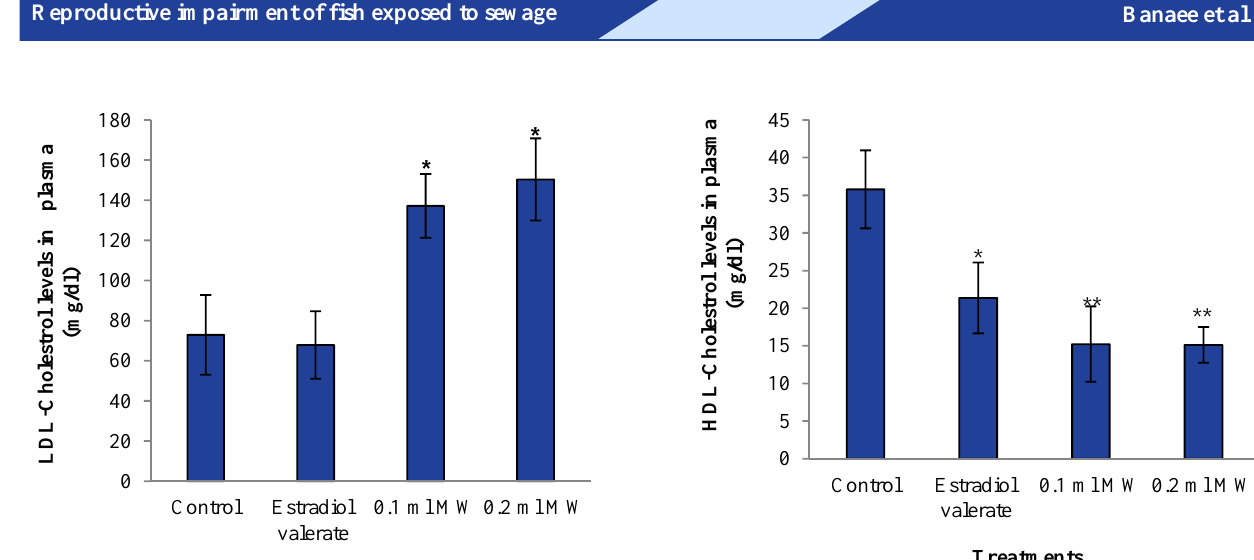
Figure 6. Plasma low-density lipoprotein cholesterol levels in immature common carp treated with estradiol valerate and different concentrations of municipal wastewater for 21 days (mean ± SD) (n = 9) Asterisk (*) indicates that the di ff erence between the experimental and control groups was significant at P < 0.05